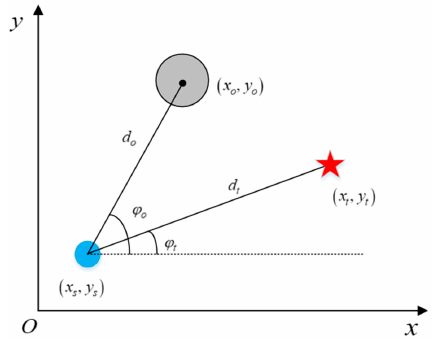
Figure 5. Schematic diagram of ship state space .